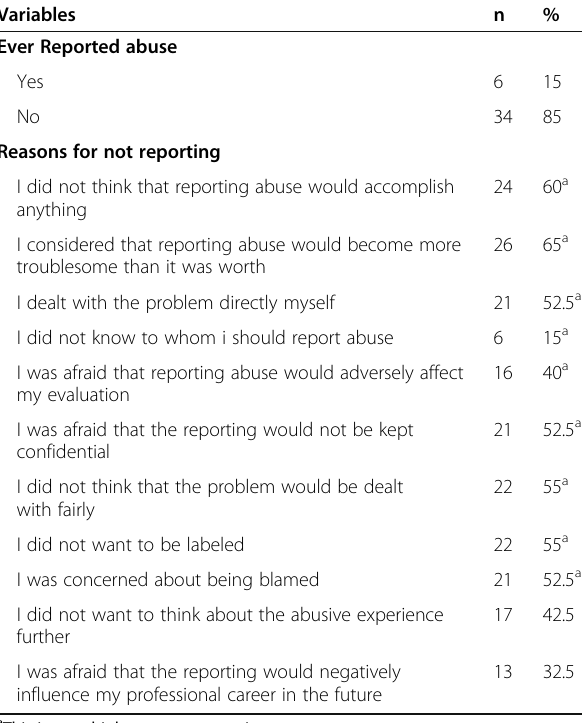
Table 4 The participants who reported any mistreatment and reasons for not